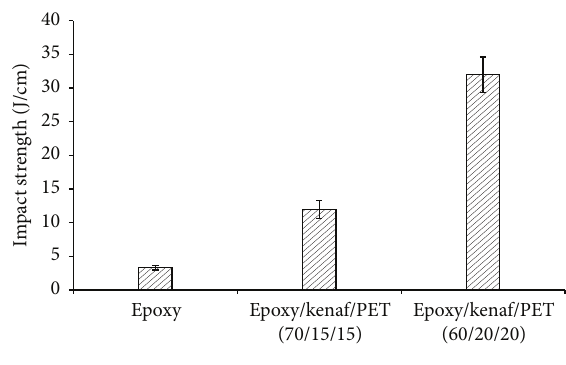
Figure 15: The results of impact strength.